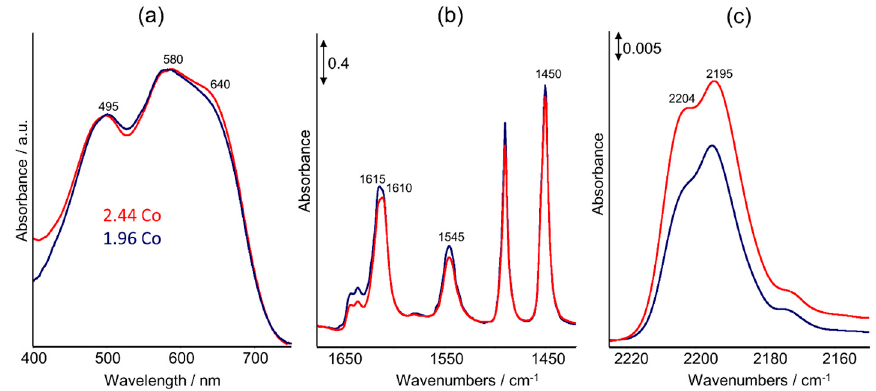
Figure 4. Comparison of UV–Vis–DR spectra measured at room temperature after heating the samples at 400 ◦ C in He for 30 min ( a ), pyridine adsorbate spectra measured at 150 ◦ C ( b ), and CO adsorbate spectra measured at − 50 ◦ C ( c ) of the samples 1.96 Co and 2.44